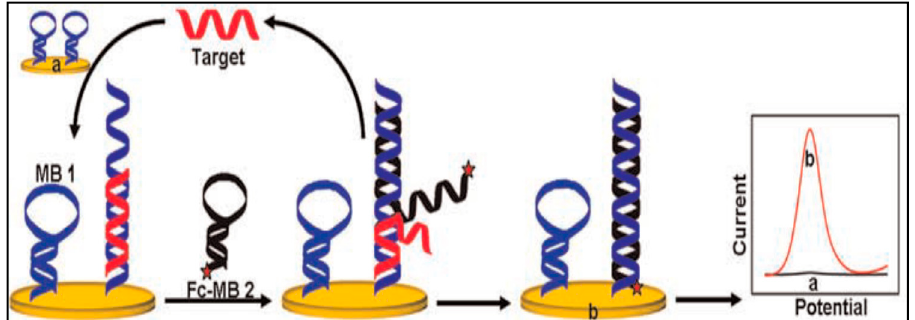
Figure 8. A signal-on electrochemical DNA sensor to detect DNA based on target catalyzed hairpin assembly strategy [149]. Copyright 2014. Reproduced with permission from Elsevier B.V.